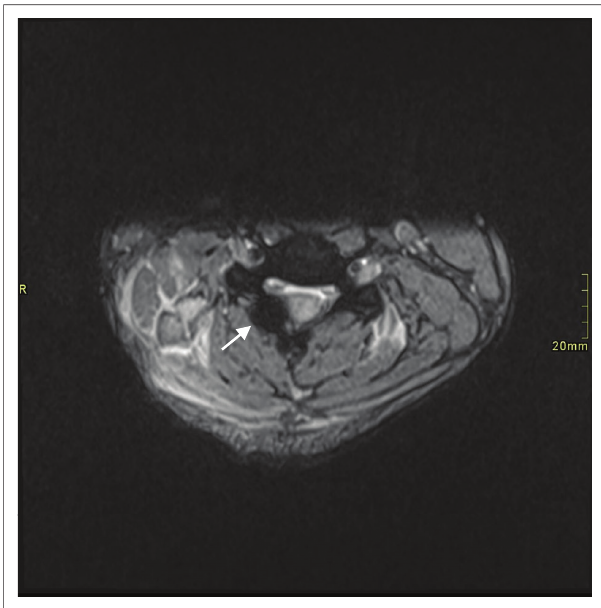
FIGURE 2: Axial gradient recalled echo image demonstrating extradural haemorrhage